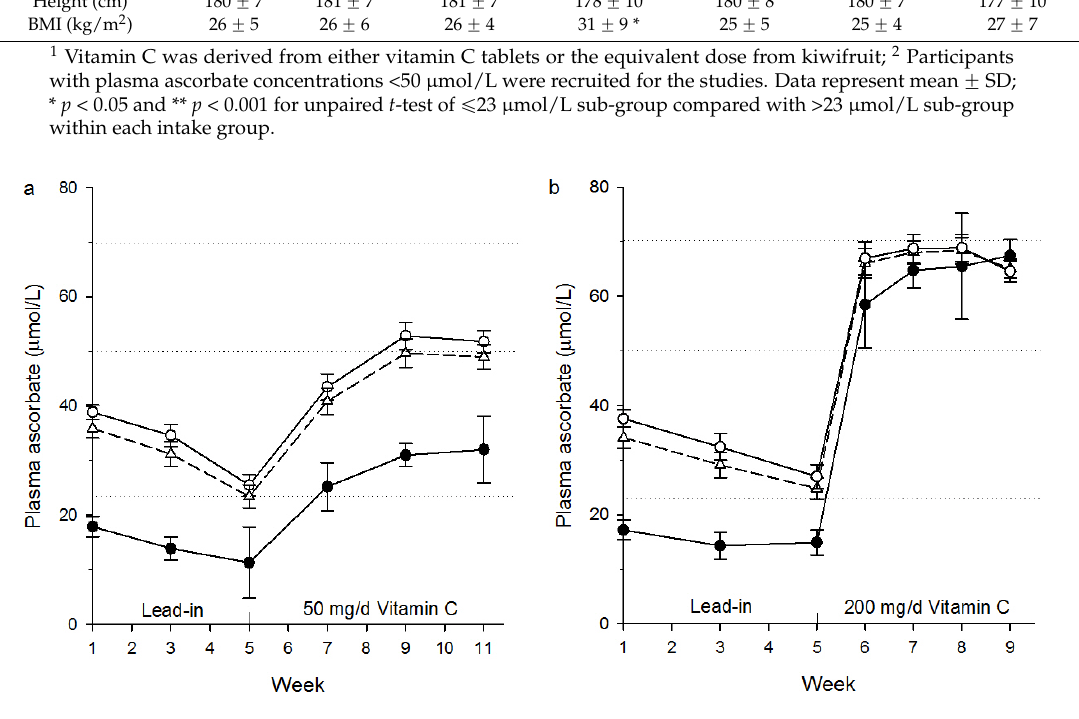
Figure 1. Plasma ascorbate concentrations in ( a ) the 50 mg/day vitamin C intervention group and ( b ) the 200 mg/day vitamin C intervention group. ( a ) Participants ( Δ , n = 35) were supplemented with 50 mg/day vitamin C for six weeks; this group was subdivided into those with >23 μ mol/L ( ○ , n = 30) or ≤ 23 μ mol/L ( ● , n = 5) plasma ascorbate at study entrance; ( b ) Participants ( Δ , n = 35) were supplemented with 200 mg/day vitamin C for a minimum of four weeks; this group was subdivided into those with >23 μ mol/L ( ○ , n = 29) or ≤ 23 μ mol/L ( ● , n = 6) plasma ascorbate at study entrance. Dotted lines demarcate ≤ 23 μ mol/L ascorbate (hypovitaminosis C), ≥ 50 μ mol/L ascorbate (‘adequate’), and ≥ 70 μ mol/L ascorbate (saturating).